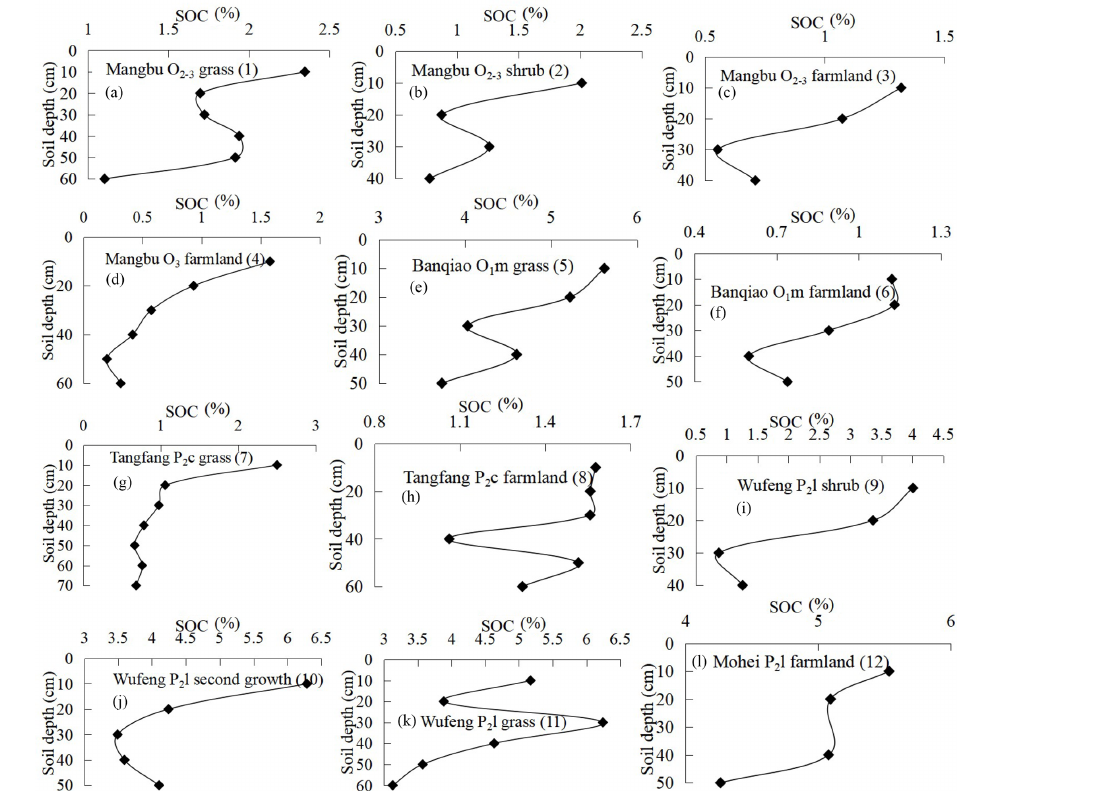
Figure 4. Varying characteristics of soil profile organic carbon in karst areas (profile no. in